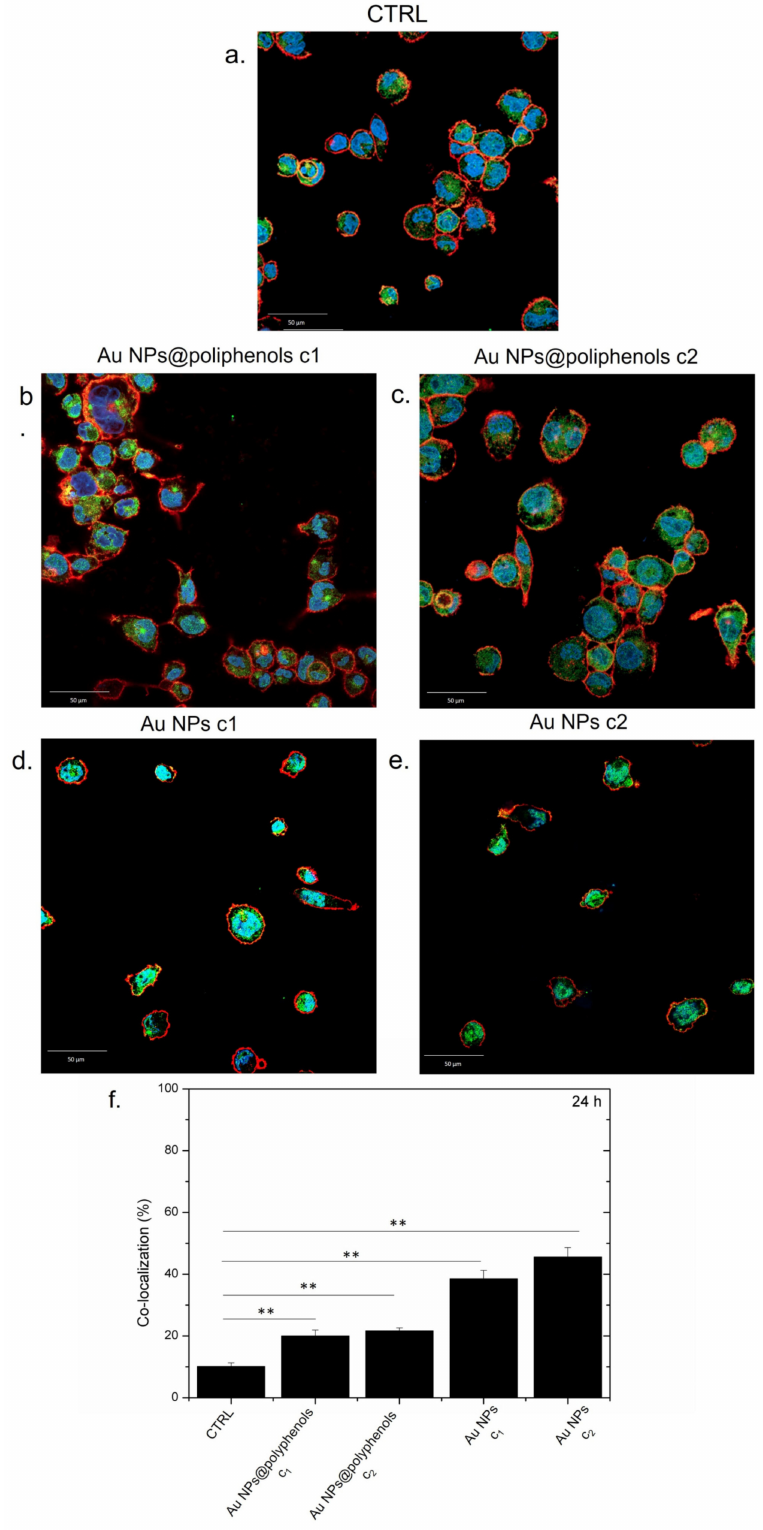
Figure 3. Representative confocal images of untreated macrophages (M0) ( a ) exposed to the c1 and c2 of Au NPs@polyphenols ( b , c ) and to the c1 and c2 of conventional Au NPs ( d , e ) for 24 h. The cells were fixed and then labeled. The nuclei were stained with Hoechst (blue), Actin cytoskeleton with CellMask™ Deep Red (red), and NF- κ B with NF- κ B p65 Antibody (F-6) FITC (green intensity signal). ( f ) Co-localization analysis of the merged fluorescence signals due to the NF- κ B translocation from the cytoplasm to the nucleus (merged blu/green fluorescence intensity signal). The data are expressed as the mean SD (5 images for n = 2) and they were considered statistically significant for ** p <